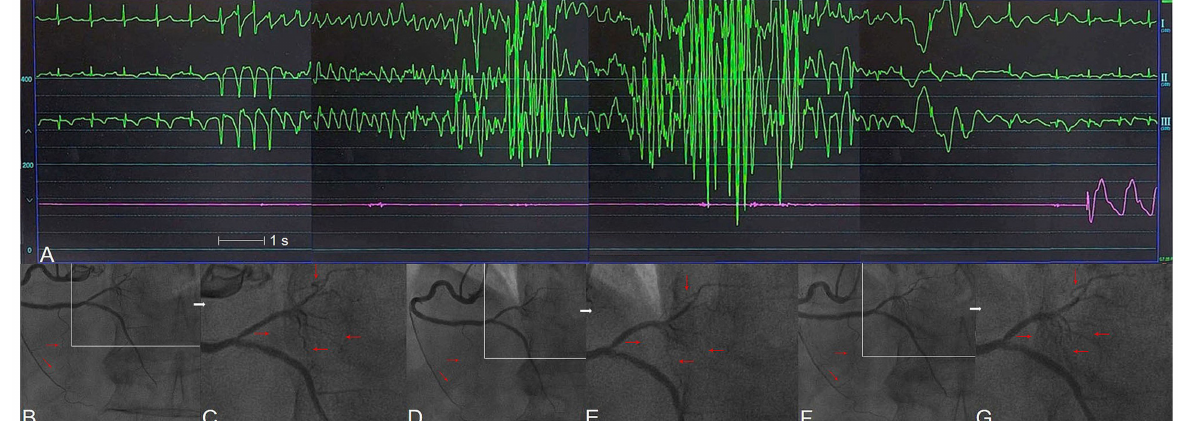
Figure 4. Microvascular CAS-induced VF: electrocardiograms (green line), pressure tracing (purple line), and right coronary arteriogram in a 75-year-old male with unstable rest angina. ( A ) Simulta- neous lead I, II, III electrocardiogram and systemic arterial pressure tracing during intracoronary ergonovine testing; ( B , C ) baseline angiographically normal right coronary artery with minimal plaquing (white and red arrows); ( D , E ) microvascular spasm (white and red arrows) immediately after intracoronary administration of 45 µ g ergonovine. Ventricular fibrillation occurred at the same time for 17 s and recovered spontaneously without intervention; ( F , G ) microvascular spasms were relieved after intracoronary administration of 200 µ g nitroglycerin (white and red arrows). The patient’s consciousness remained clear throughout the